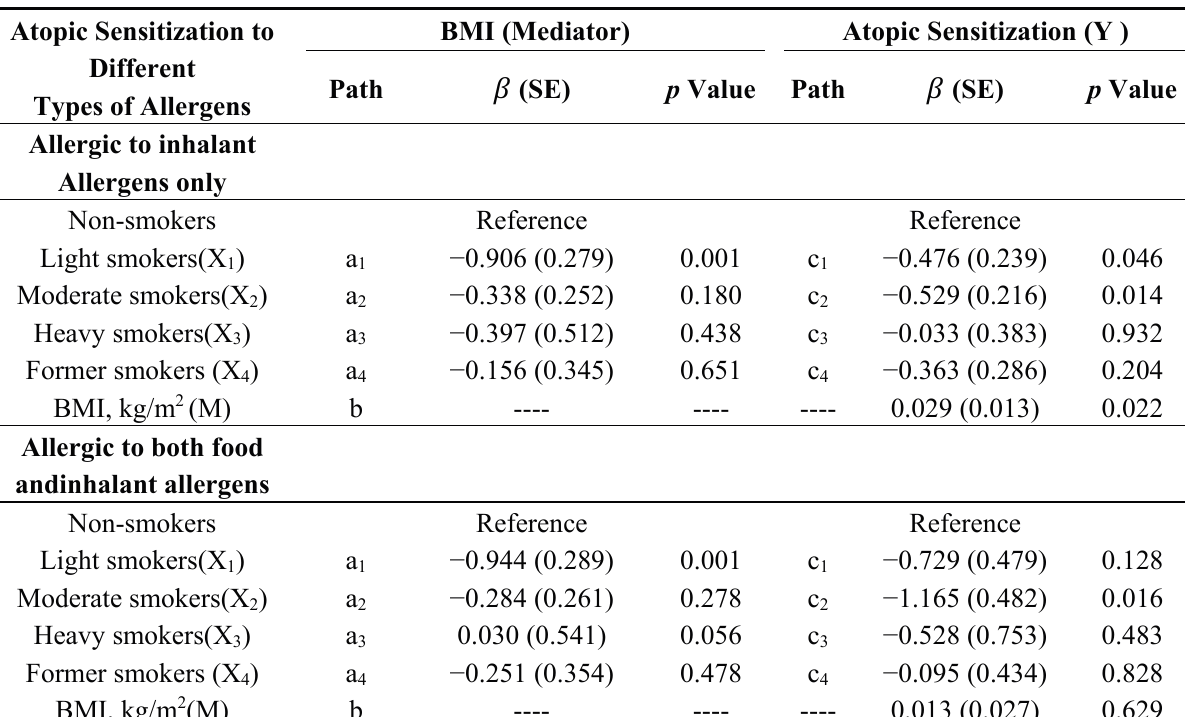
Table 2. Association between each smoking category, atopic sensitization to different types of allergens and BMI in mediation model 1